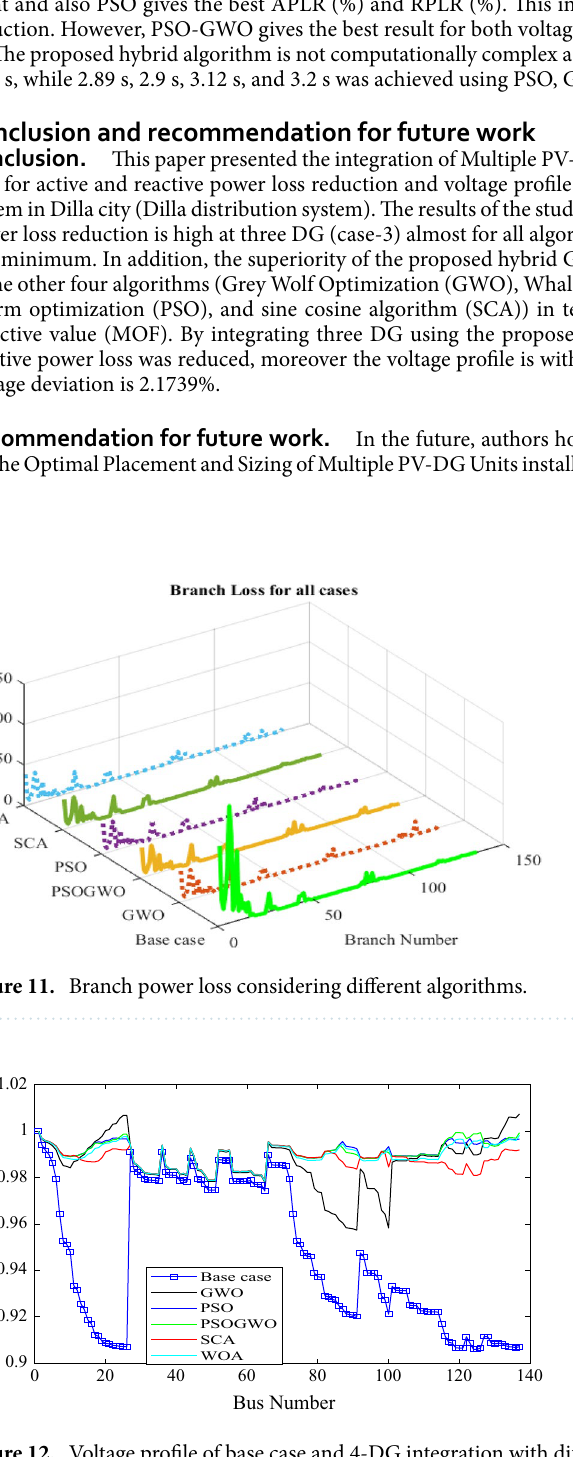
Figure 12. Voltage profile of base case and 4-DG integration with different